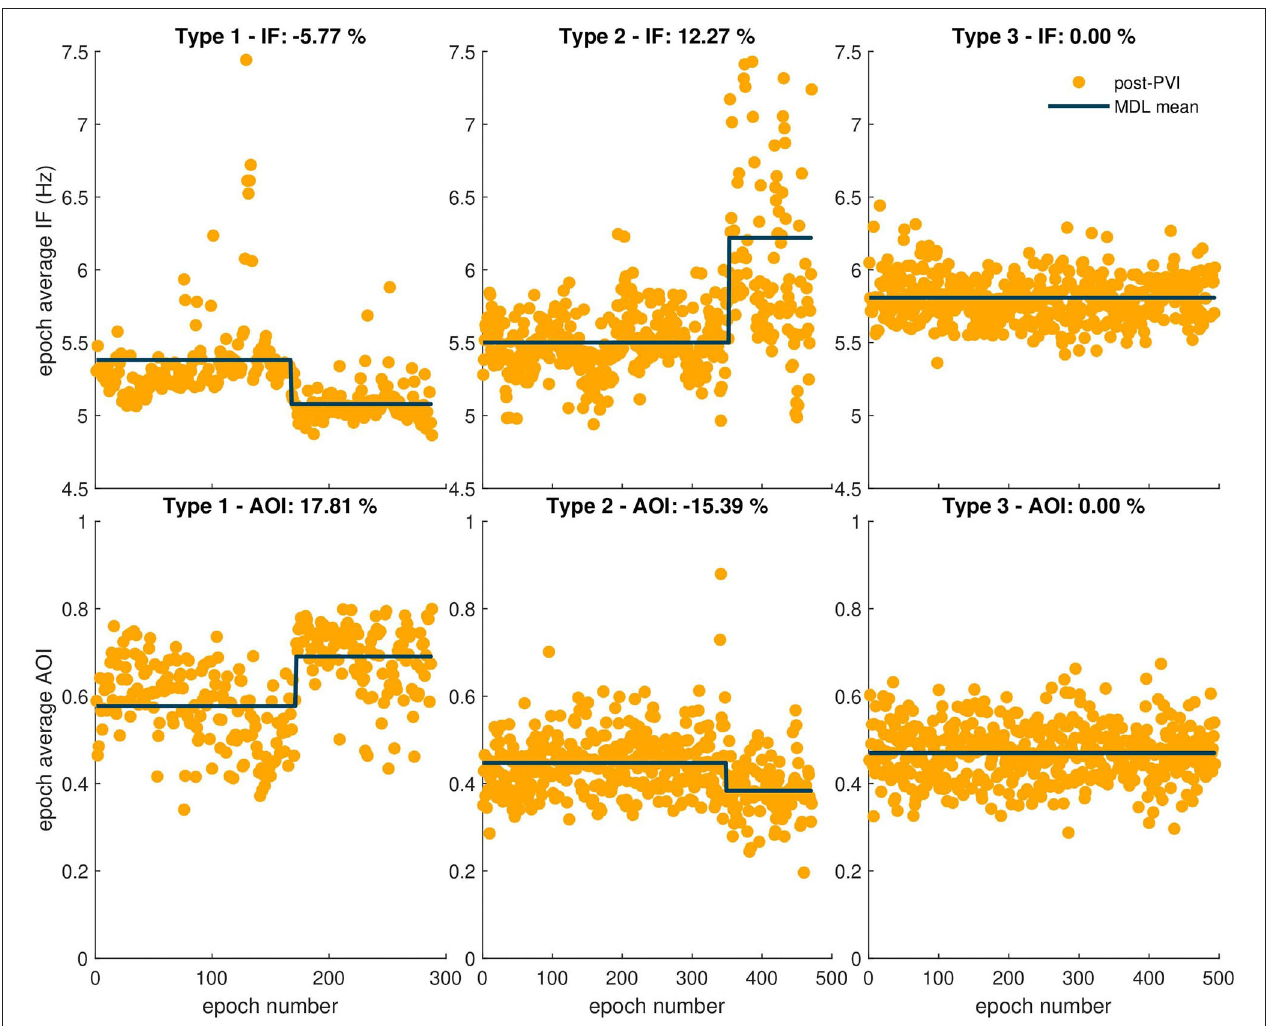
FIGURE 6 | Three types of AF organization. The observed relative percent change is indicated in the title of each example. The first column shows examples of Type 1, increasing AF organization, indicated by a negative IF transition in the first row and a positive AOI transition in the second row. The second column shows examples of Type 2, decreasing AF organization, indicated by a positive transition in the IF epoch sequence, and negative transition in the AOI epoch sequence. Finally, the third column shows examples of Type 3, no change in AF organization, indicated by no transitions in either